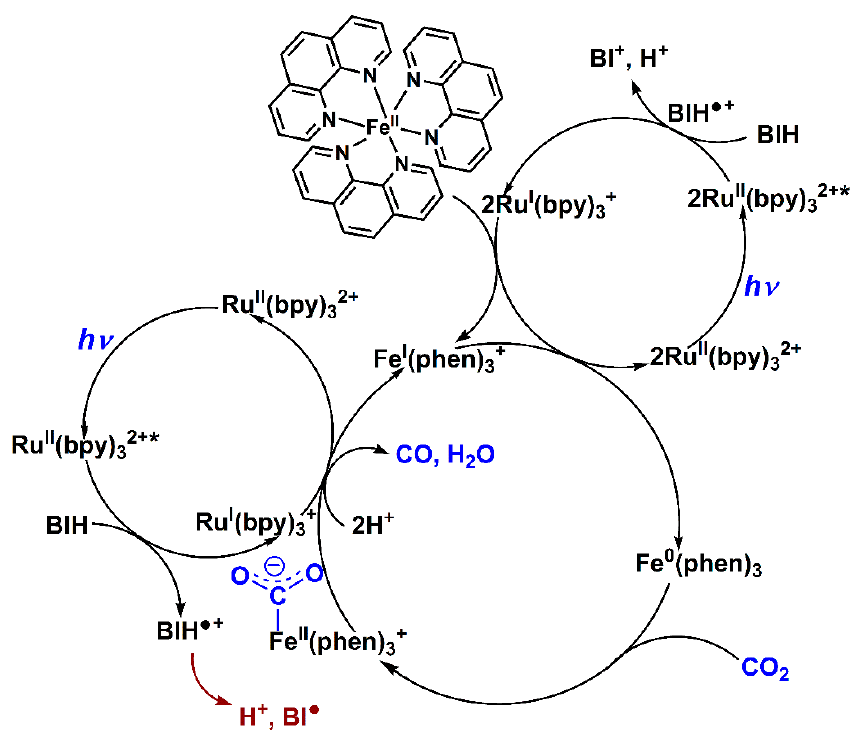
Figure 4. HRMS spectra of CO 2 -saturated DMF/TEOA solution ( v/v , 7:1) containing 0.67 mM Ru(bpy) 32+ , 0.022 M BIH and 1.5 × 10 − 7 M Fe(phen) 32+ after irradiation for 30 min. Inset: measured isotopic distribution.